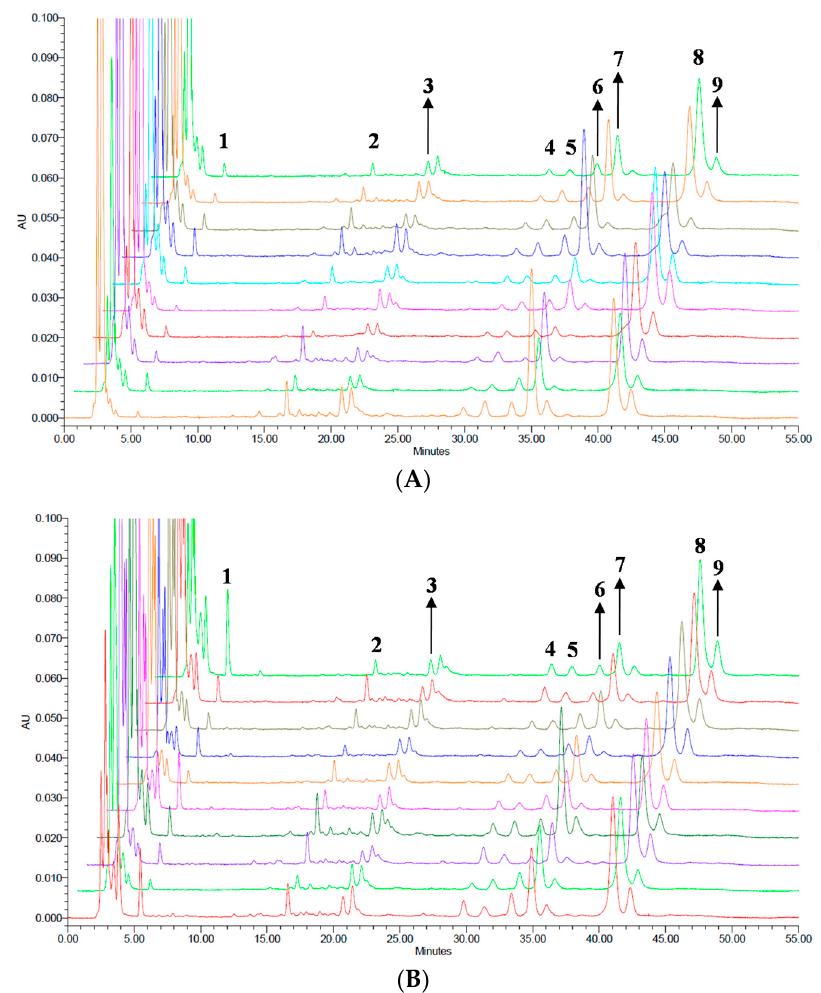
Figure 3. HPLC chromatogram fingerprint profiles of ( A ) 10 batches of HZR and ( B ) 10 batches of HZB. The number 1–9 indicate the common fingerprinting peaks for identification. Peak 1: Quercetin, peak 4: Ugonin J, and peak 7: Ugonin M.